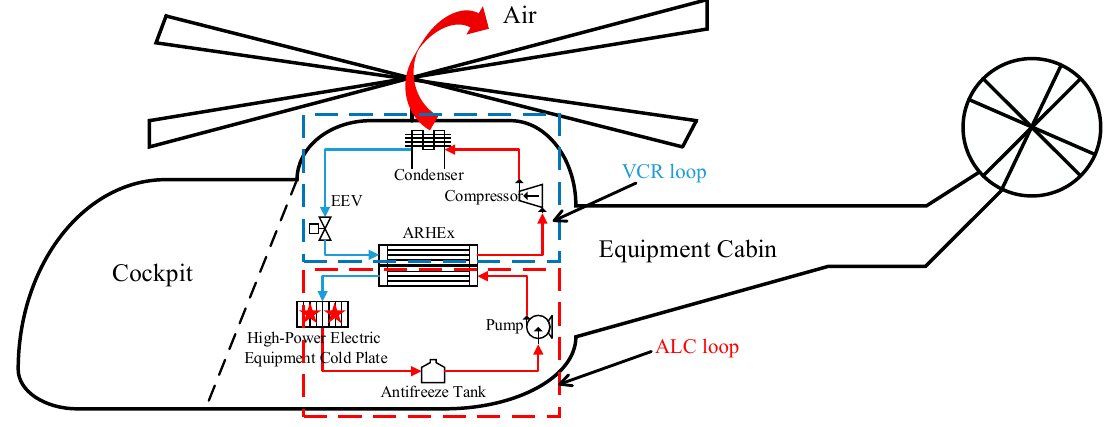
Figure 1. Helicopter thermal management system (TMS).